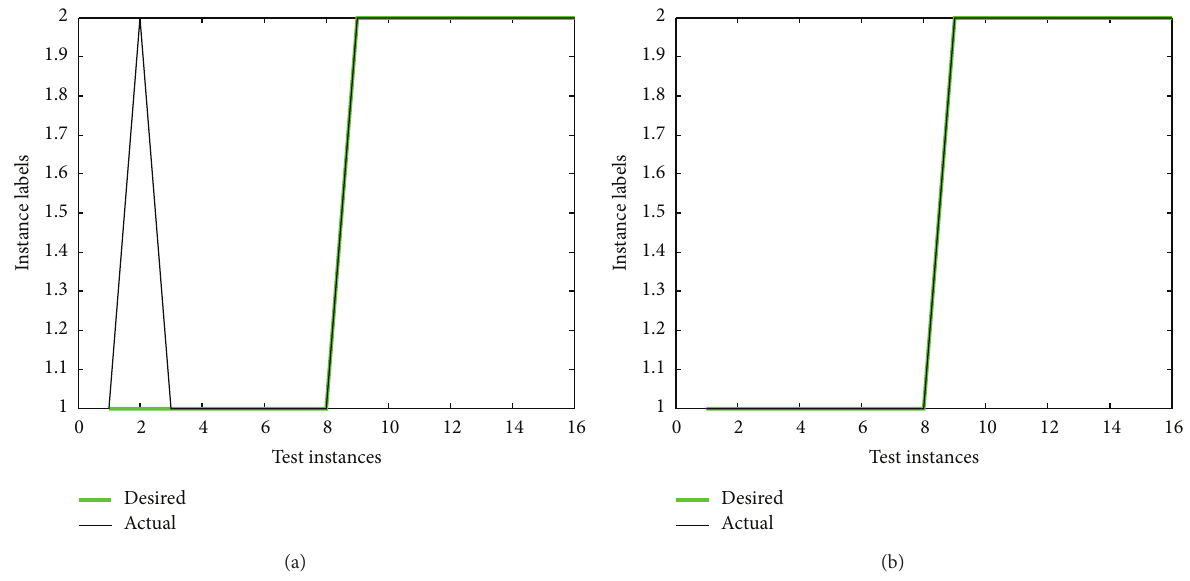
Figure 6: (a) Output after 100 epochs using proposed kernel: misclassification exists. (b) Output after 150 epochs using proposed kernel: 100% accuracy is achieved.